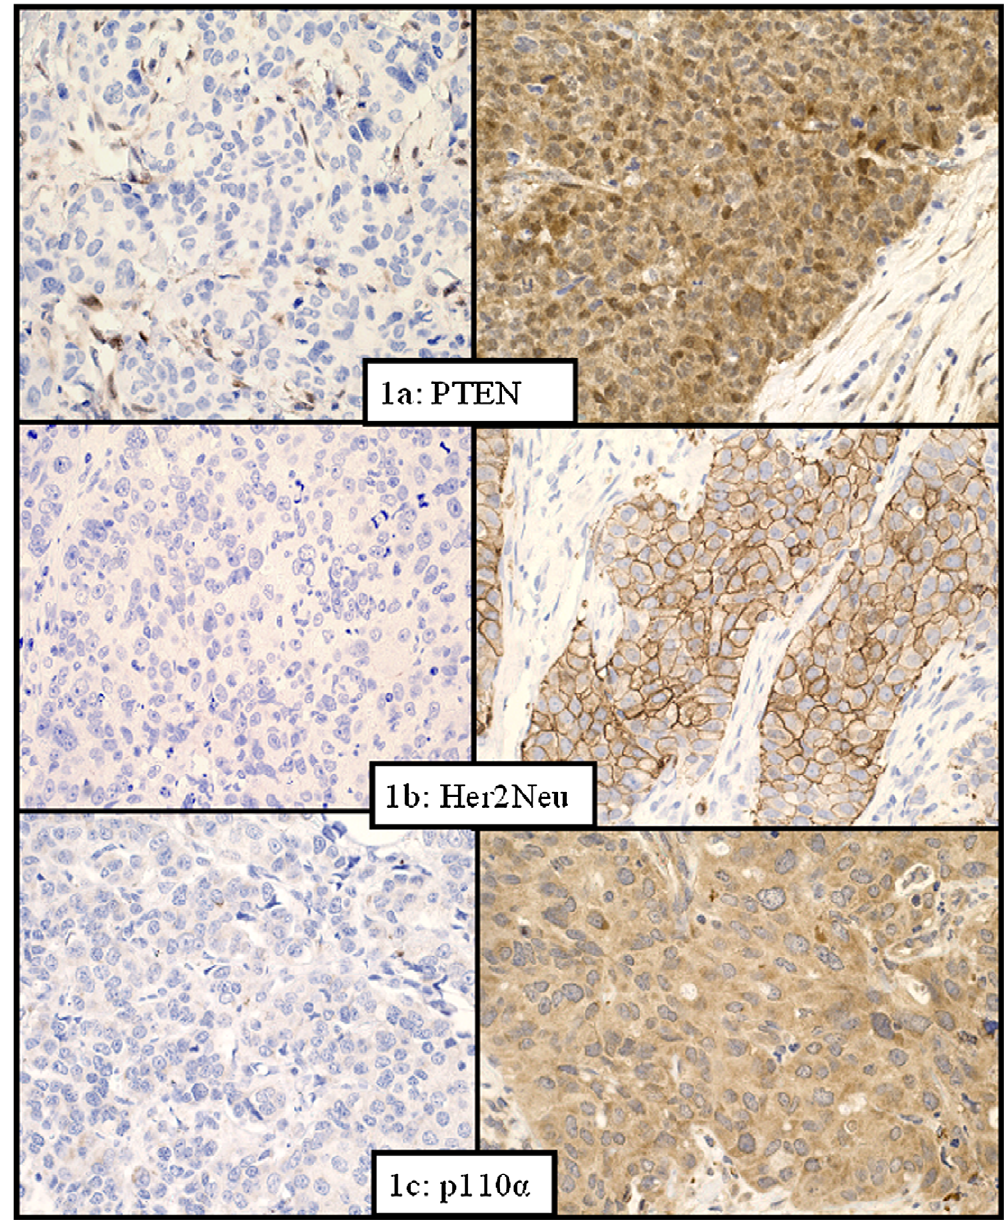
Fig. 1. Representative immunohistochemical samples. At the left, a negative or weakly positive sample is shown. (A) A typical PTEN-positive tumor with both cytoplasmic and nuclear staining. (B) A strongly positive (3 + ) Her2neu stained-tumor. (C) A tumor showing strong positive staining for p110alpha. (D) Simultaneous cytoplasmic and nuclear staining for pAkt. (E) Strong staining for mTor. (F) A tumor with a high percentage of p27 staining in both the cytoplasm and the nucleus. (G) Cyclin-E nuclear staining in more than 10% of tumor